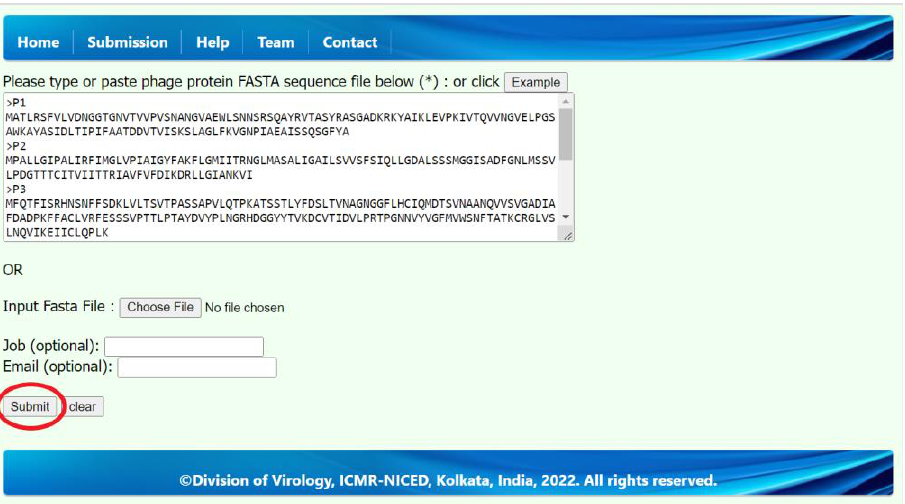
Figure 3. The submission page of the web server. Example phage protein sequences are also shown in the text field.